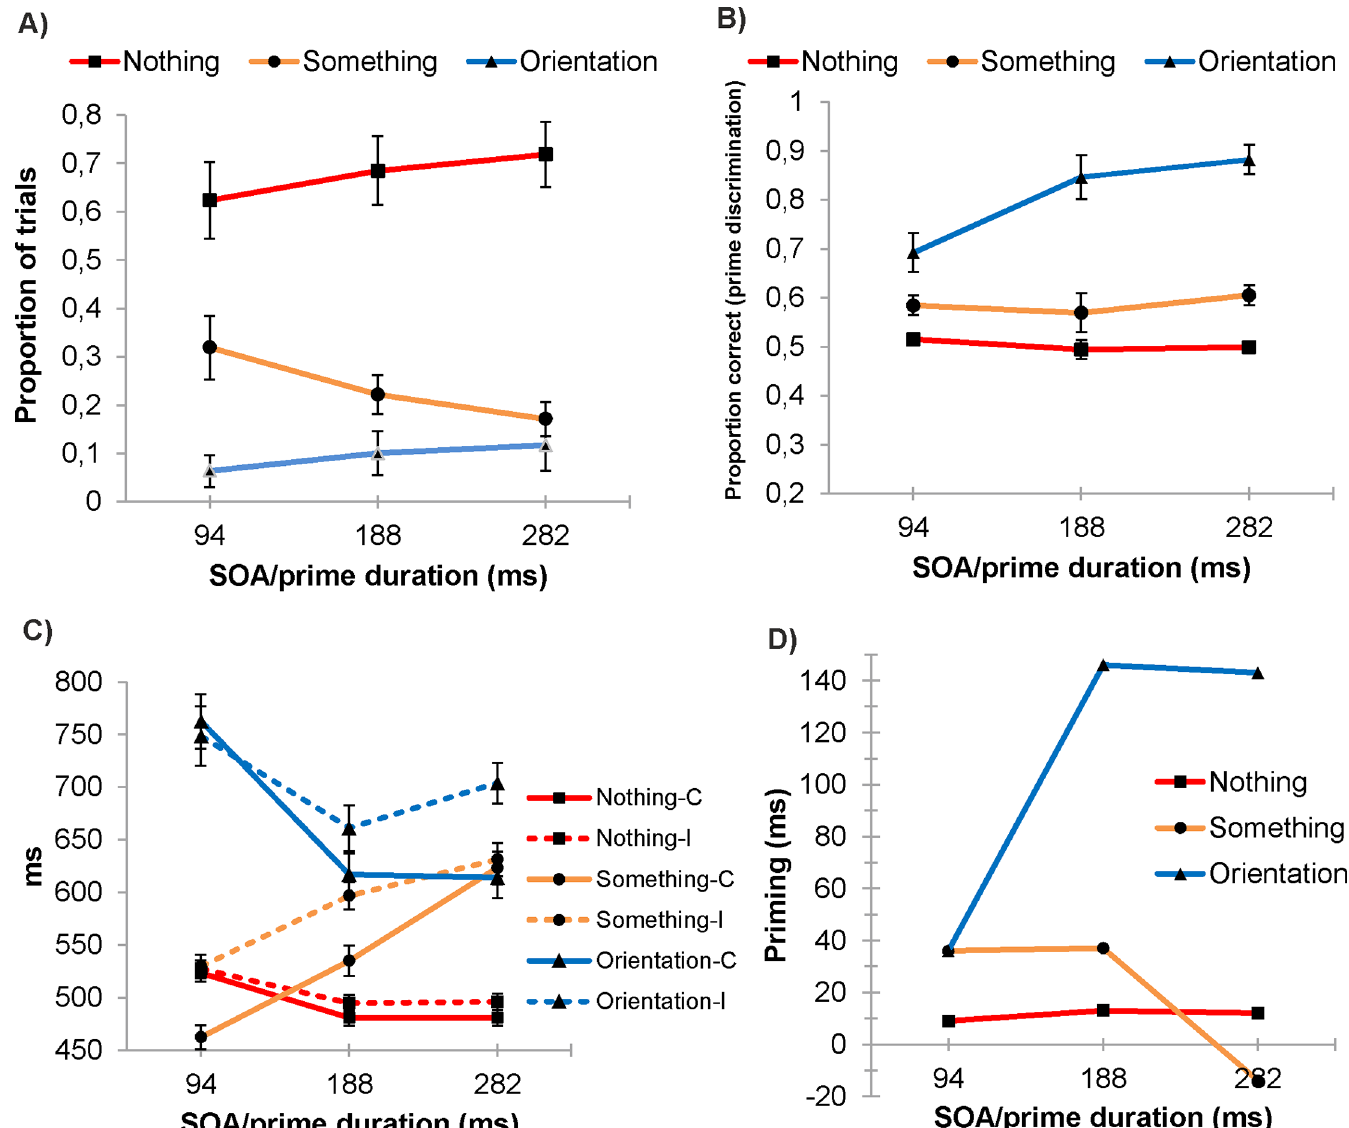
Fig 2. Results. (A) Rated consciousness of the prime in the critical trials as a function of SOA/prime duration. The participants reported that they either did not see anything presented (= nothing), they saw a glimpse of something (= something), or they think they saw or could guess the orientation of the prime (= orientation). (B) Accuracy of the two-alternative forced-choice responses to the orientation of the prime. (C) Observed response times to congruent (c; solid line) and incongruent (i; dotted line) targets, and (D) modeled priming effects. Error bars represent SEM.